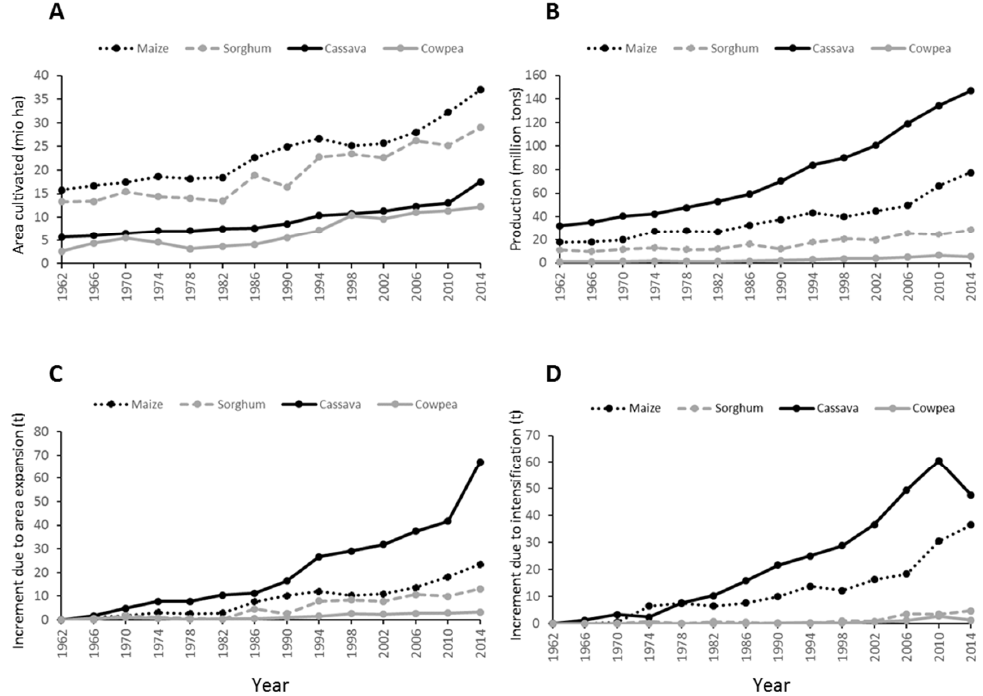
Figure 4. The contribution of crop intensification in four crops predominantly cultivated in Africa. ( A ) area of cultivation; ( B ) total production; ( C ) increment due to area expansion; and ( D ) increment due to intensification which includes improved varieties and management practices. Calculations for ( C , D ) are based on the yields of 1962 where they were 1.11 t/ha for maize, 0.83 t/ha for sorghum, 5.66 t/ha for cassava, and 0.33 t/ha for cowpea. Source for ( A , B ): FAOSAT.